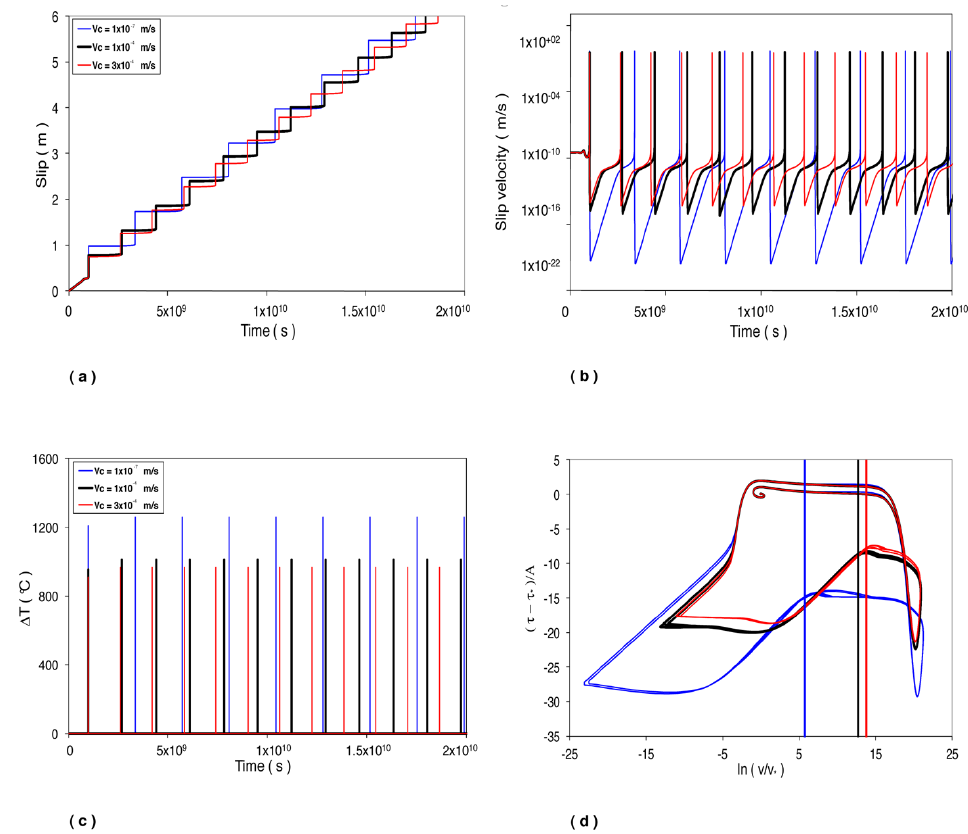
and unchanged c , with respect to the reference value of Table 1. Black, reference Figure 5. As for Figure 4, with changed v c